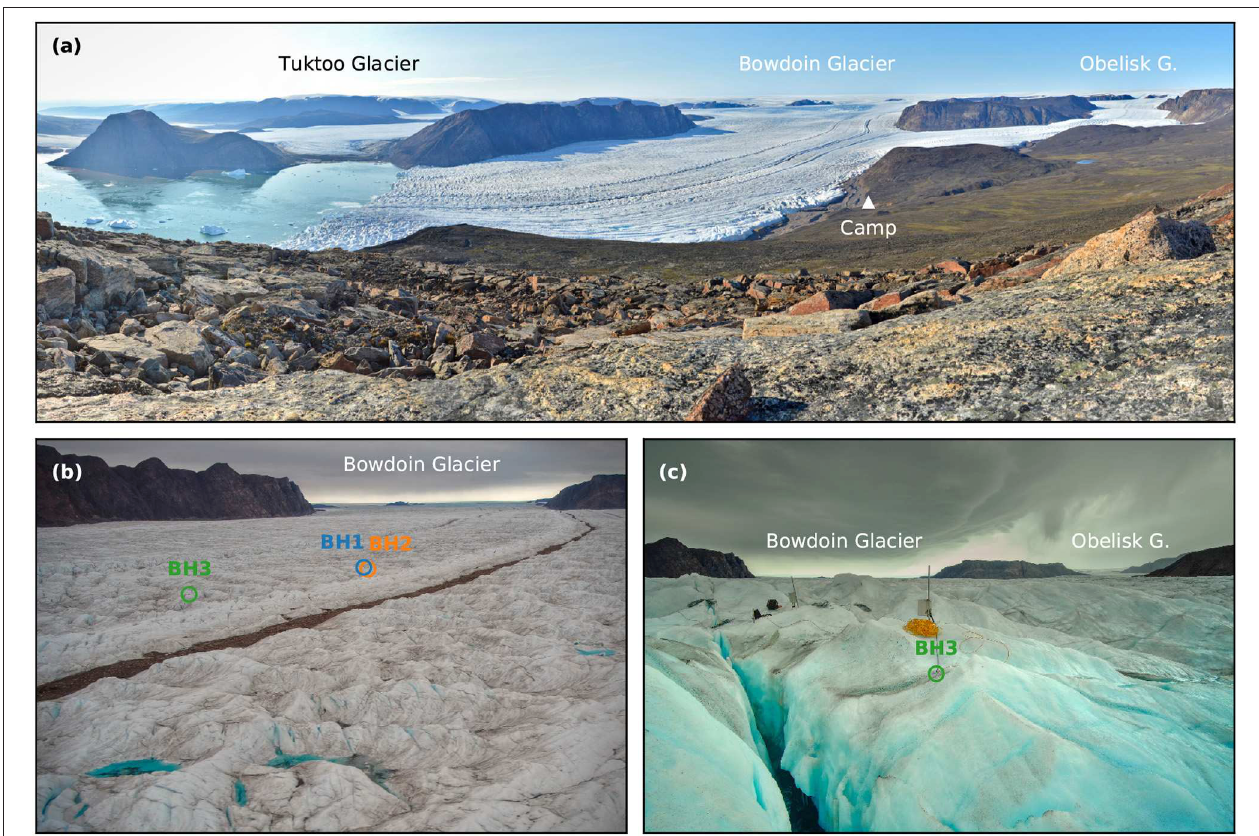
FIGURE 1 | (a) Bowdoin Glacier panoramic view on 2015 July 17. The calving front is ca. 3km wide and 50m high. Note the steeper section of the glacier above the confluence of Obelisk Glacier. (b) Bowdoin Glacier lower drilling site and BH3 data loggers for thermistor strings and the basal piezometers on 2016 July 19. The data logger for the digital inclinometers was removed after cable damage related to the opening of the crevasse pictured. (c) Aerial view of the drilling sites on 2016 July 21. The location of BH1 and BH3 could be inferred from visible field installations.